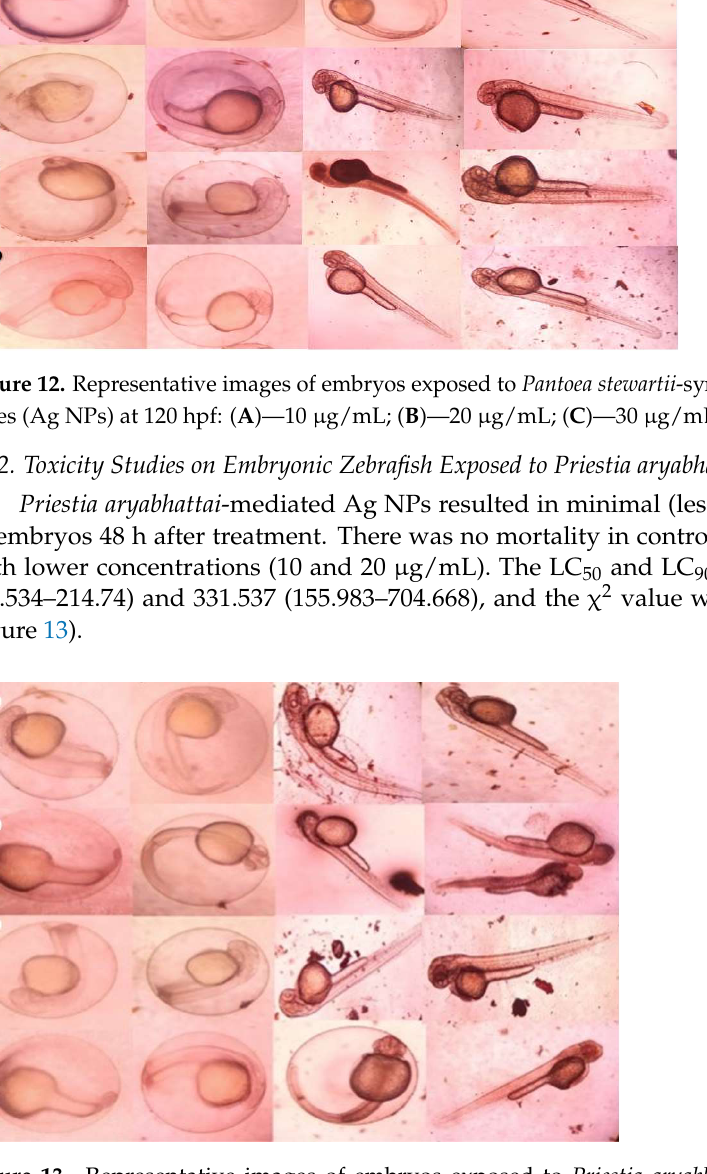
Figure 13. Representative images of embryos exposed to Priestia aryabhattai -synthesized silver nanoparticles (Ag NPs) at 120 hpf. ( A )—10 µ g/mL; ( B )—20 µ g/mL; ( C )—30 µ g/mL; ( D )—50 µ g/mL.